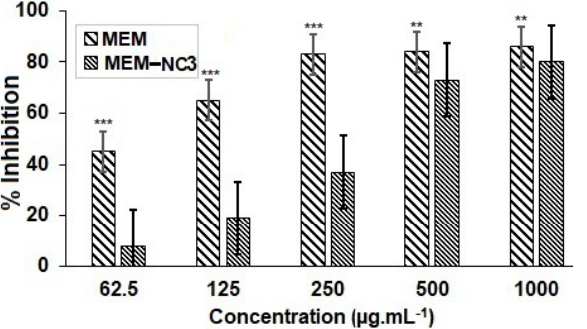
Figure 5. Percentage inhibition of RPMI 2650 cells on pure MEM and MEM-NC3 at various con- centrations (mean ± SD, n = 3). The significant variances associated with control (pure MEM) are denoted by *** p < 0.005 and ** p < 0.05 as estimated by the ANOVA test. Their morphological changes were microscopically examined (Figure 6), which con- firmed cytotoxic effects of MEM and MEM-NC3 when the dose is at least as high as 500 mg/mL. Microscopic images of RPMI 2650 cells exposed to MEM and MEM-NCs after 72 h of treatment exhibited significant cytotoxicity in a dose-dependent manner, which are